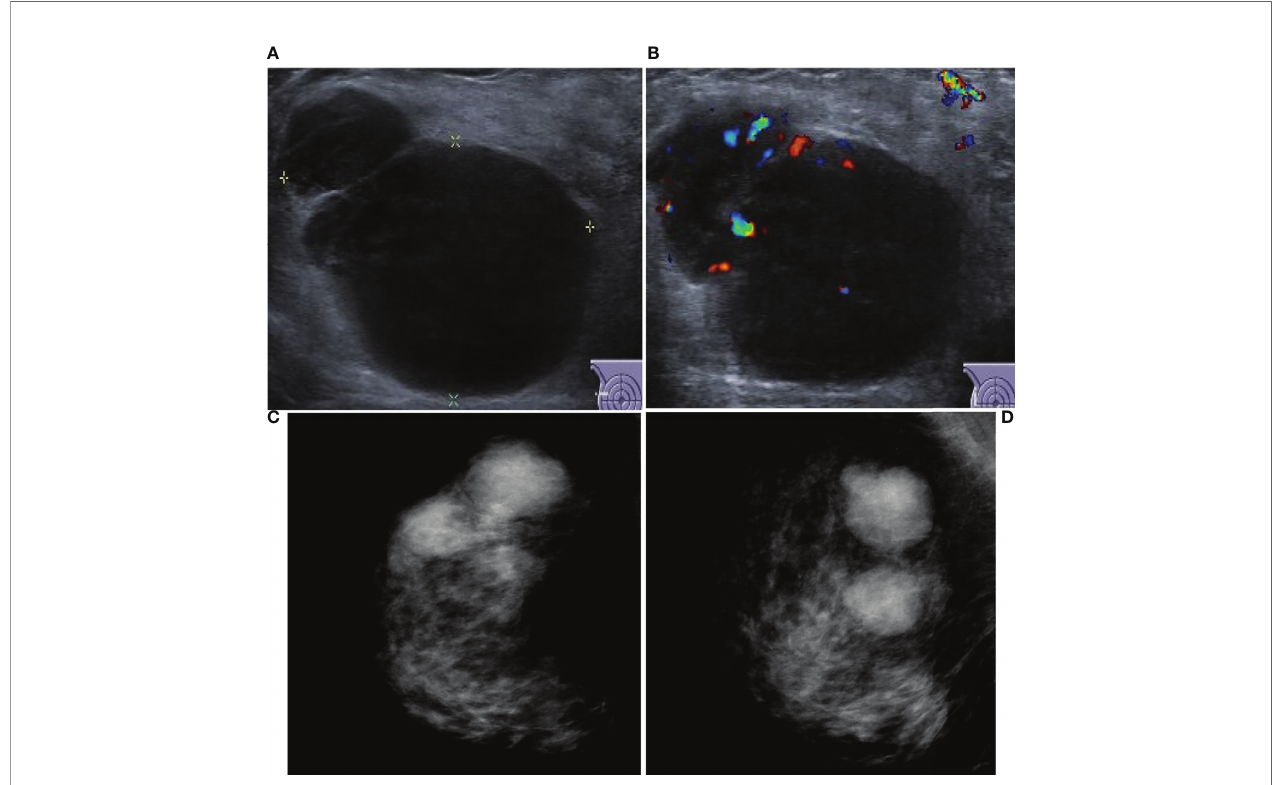
FIGURE 3 | Ultrasound and mammography images for PBL. Legend: Female, 49, right non-Hodgkin breast lymphoma. (A) shows irregular hypoecho in the right breast with circumscribed margins. (B) CDF1 shows abundant blood fl ow signals. Right breast mammography CC position (C) and MLO position (D) image showed high density mass, no micro/macro-calci fi cation.